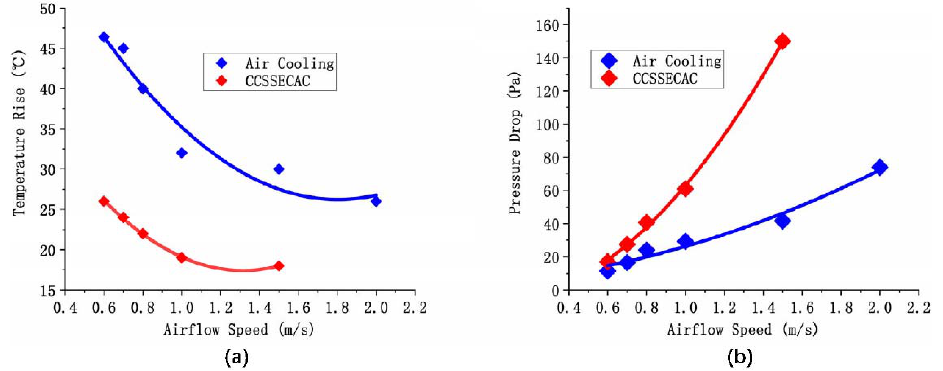
Figure 8. Comparison under the rated working conditions: ( a ) temperature rise at different airflow speeds and ( b ) airflow friction losses at different airflow speeds.